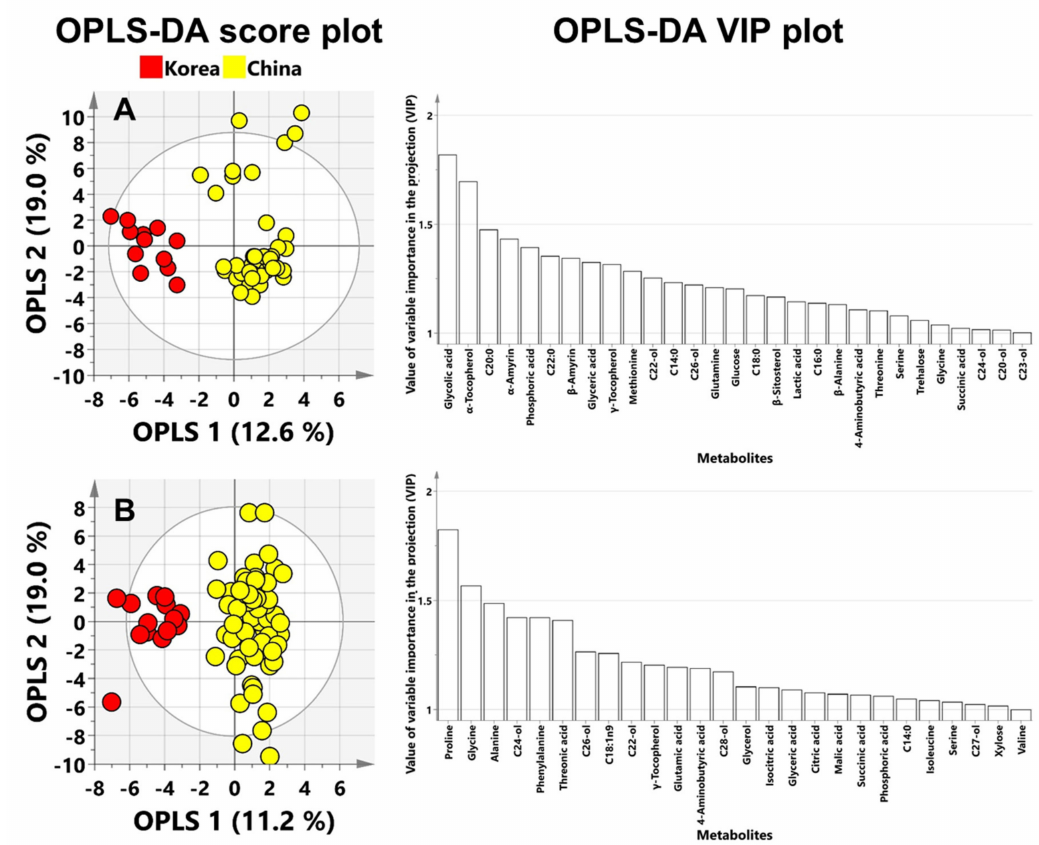
Figure 1. OPLS–DA score plots and VIP (variable importance in the projection) plots of ( A ) perilla and ( B ) sesame seeds from Korea and China. C20-ol—eicosanol; C21-ol—heneicosanol;